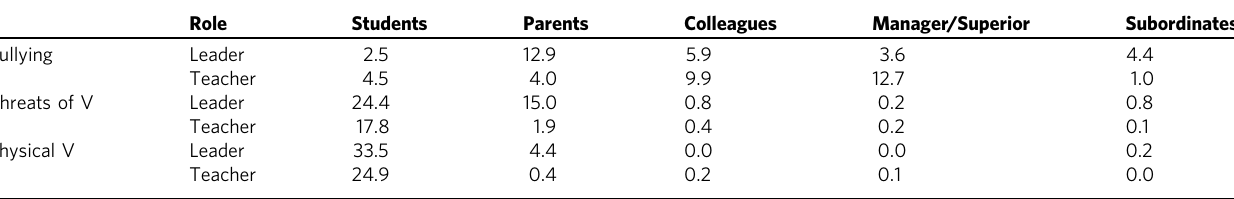
Table 5 Proportion of school leaders and teachers reporting offensive behaviors from each different perpetrator